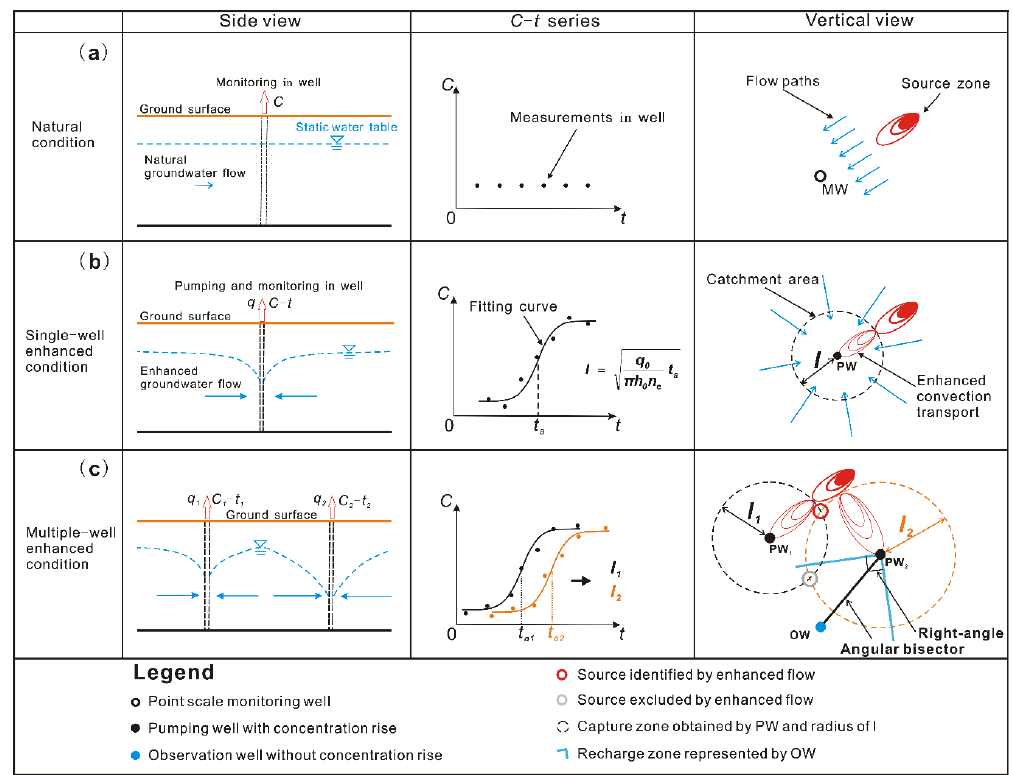
Figure 1. Concept map of source localization by concentration time series interpretation from two pumping wells (PW) with pumping rate of q 1 and q 2 . ( a ) Point scale sampling from monitoring wells (MW) in site of low-permeability aquifer. ( b ) Distance ( l ) from potential source to pumping well is calculated by groundwater well flow theory and concentration time ( C - t ) series fitting. ( c ) The potential source is identified by the crossing of catchment areas obtained from two pumping wells and further selected by observation wells (OW).